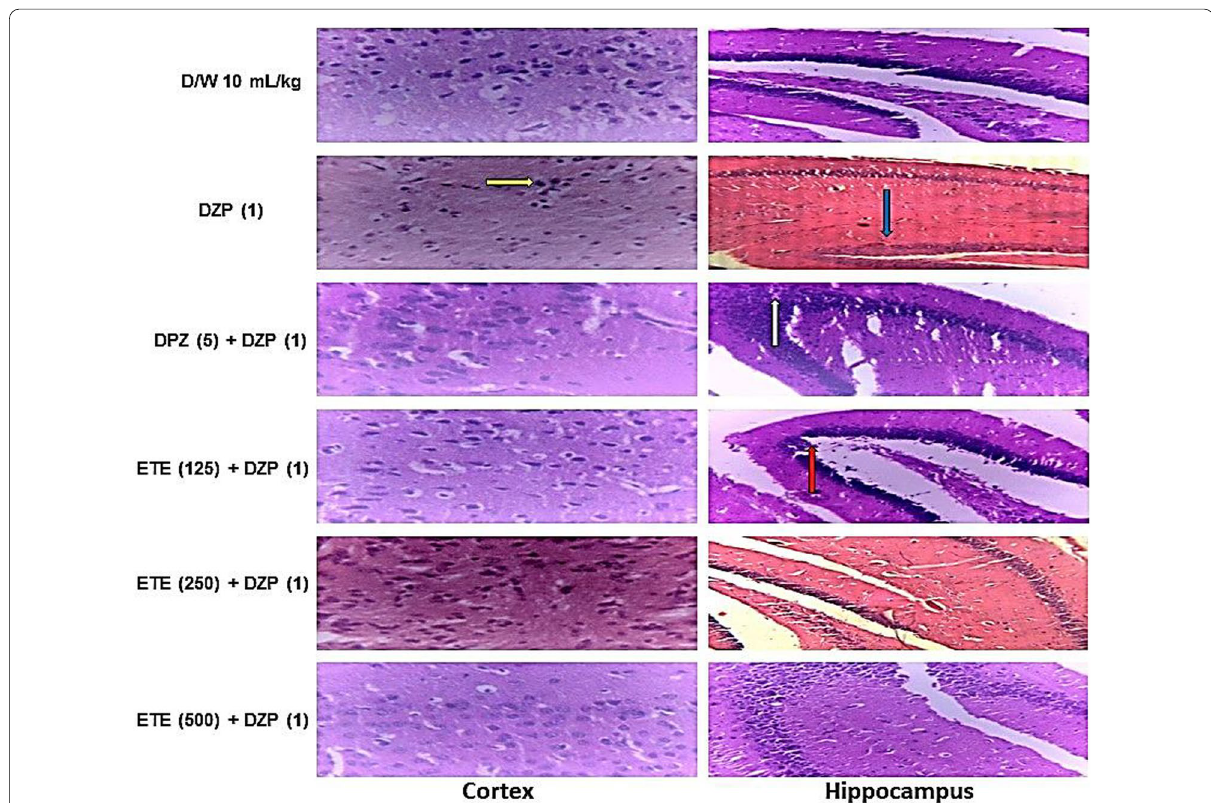
Fig. 6 Photomicrograph of brain sections showing the effect of Eragrostis tremula following diazepam-induced amnesia in mice. D/W group showing normal cortex and pyramidal cells; DZP Diazepam-alone group showing atrophy of neuron (yellow arrow) and loss of pyramidal = cells (blue arrow); DPZ donepezil treated group showing slight hyperplasia of pyramidal cells; ETE 125 mg/kg = moderate pyramidal cell necrosis (red arrow); ETE 250 and 500 mg/kg E. tremula treated group showing normal features; (H&E =